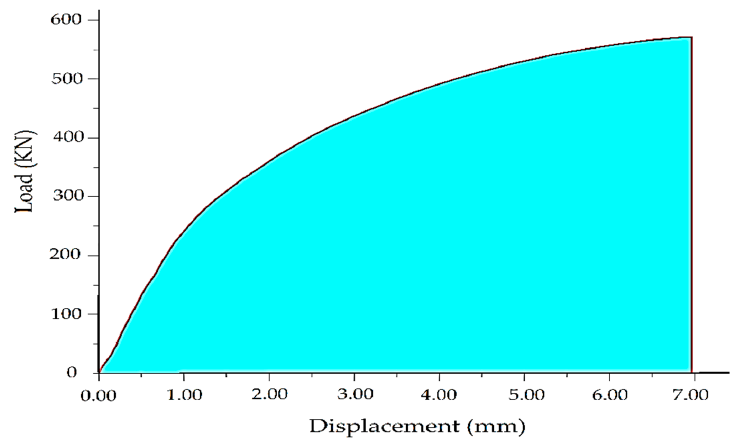
Table 7. Average values of all tested specimens.